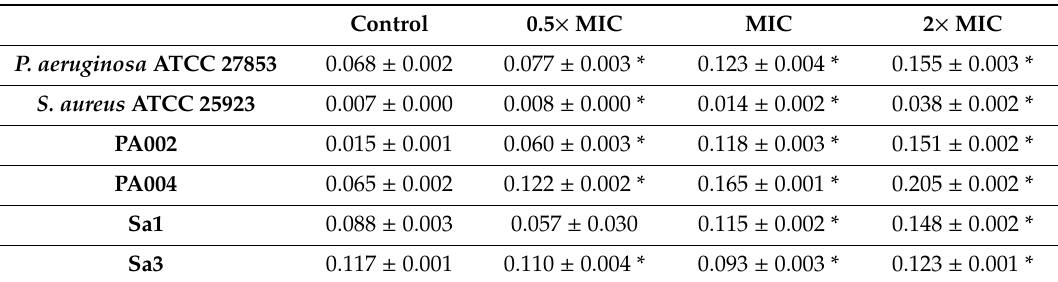
Table 2. Laurdan generalized polarization (GP) values obtained for di ff erent bacterial strains in the presence and absence of peptide Hs02 (in concentrations equal to 0.5 × MIC, MIC, and 2 × MIC). GP values allow the measurement of membrane